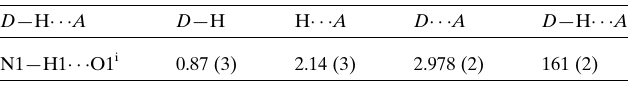
Table 2 Hydrogen-bond geometry (A˚ , (cid:2) ) for (II).